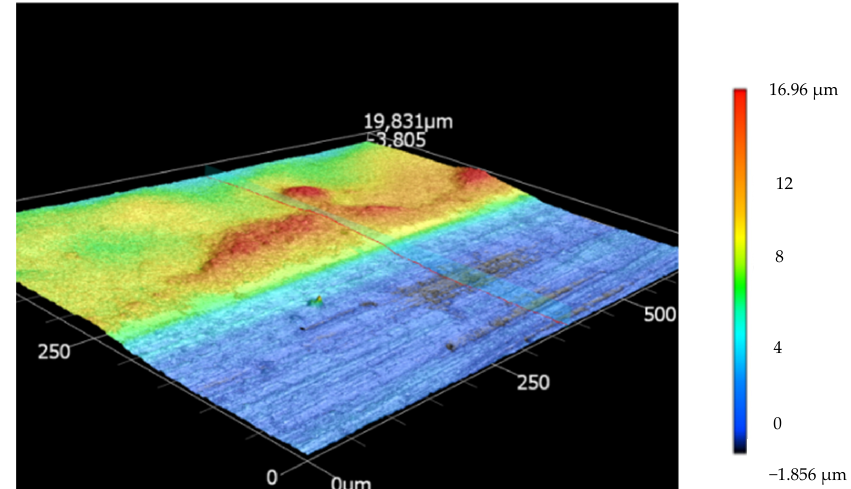
Figure 3. NF270 3D image. 20× measured by 3D laser-scanning microscope.